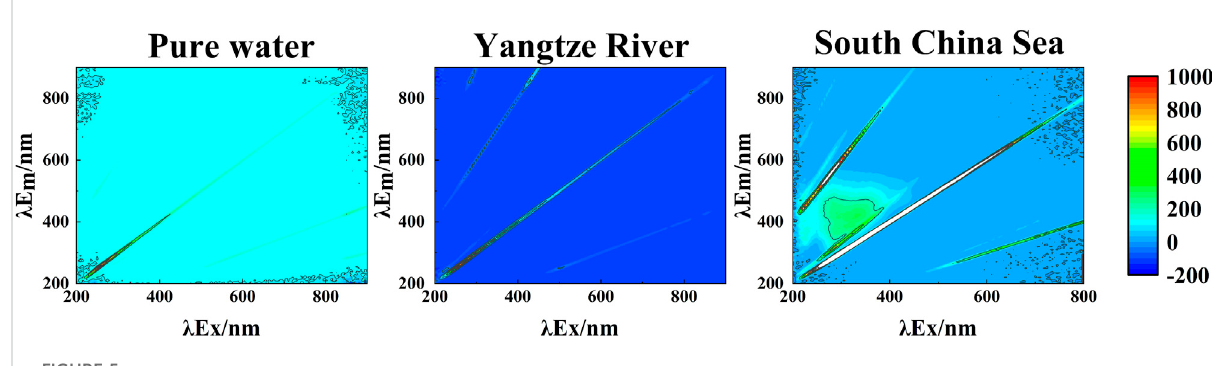
Fluorescence intensity measurements of different samples.